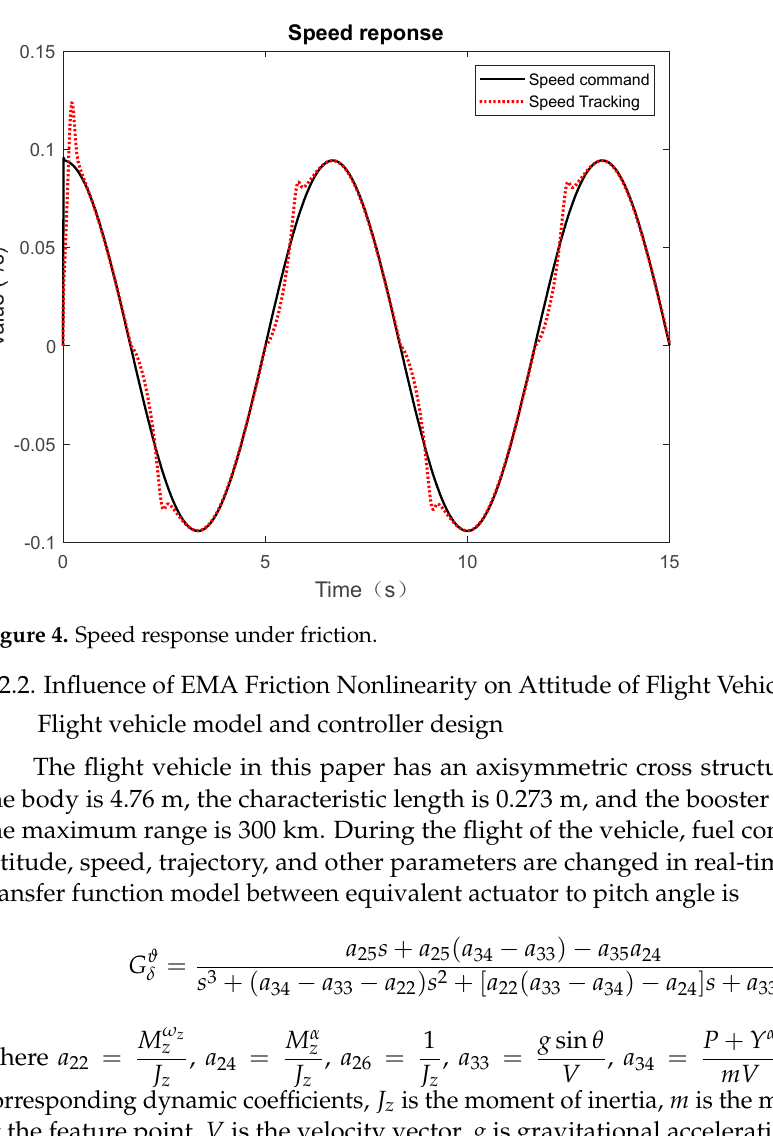
Figure 3. Position response under friction.